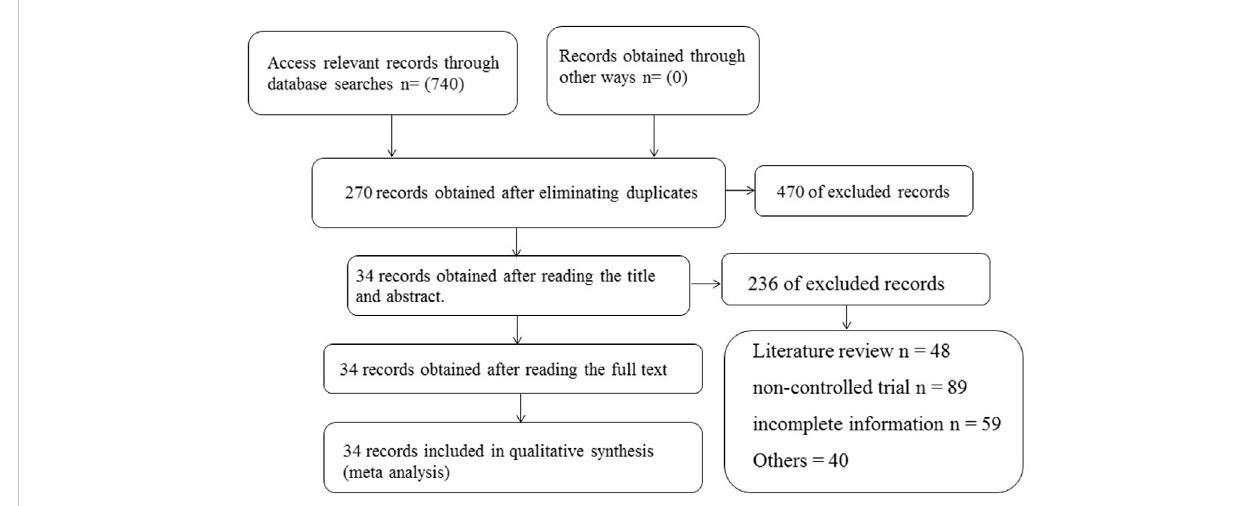
FIGURE 1 Flow chart of trials selection process for meta-analysis.